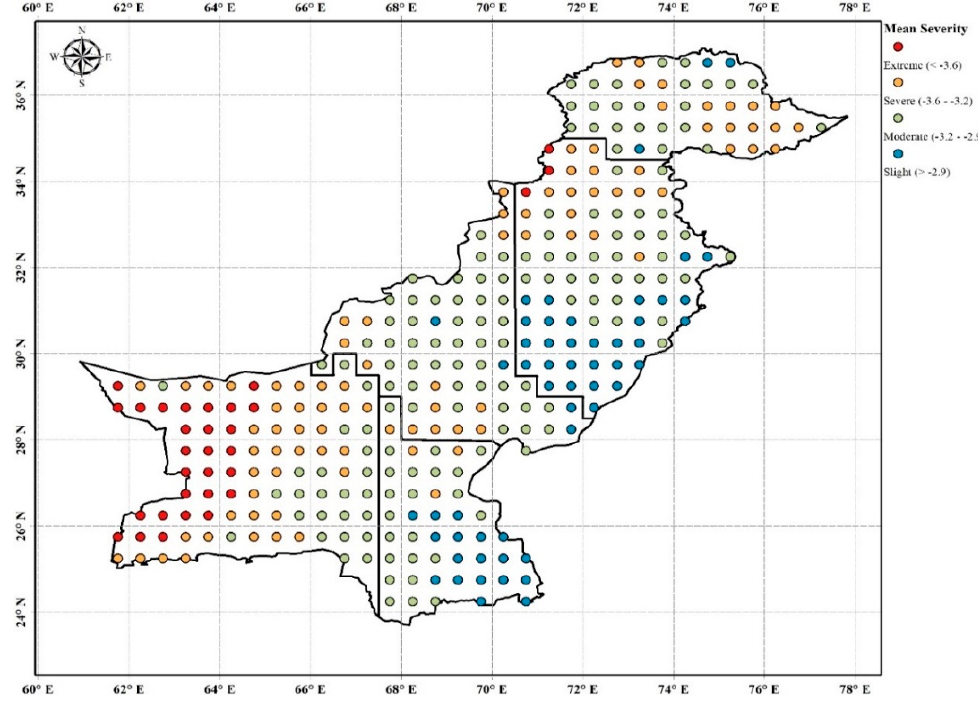
Figure 9. Mean severity of droughts that occurred from 1902–2015 at each grid cell.